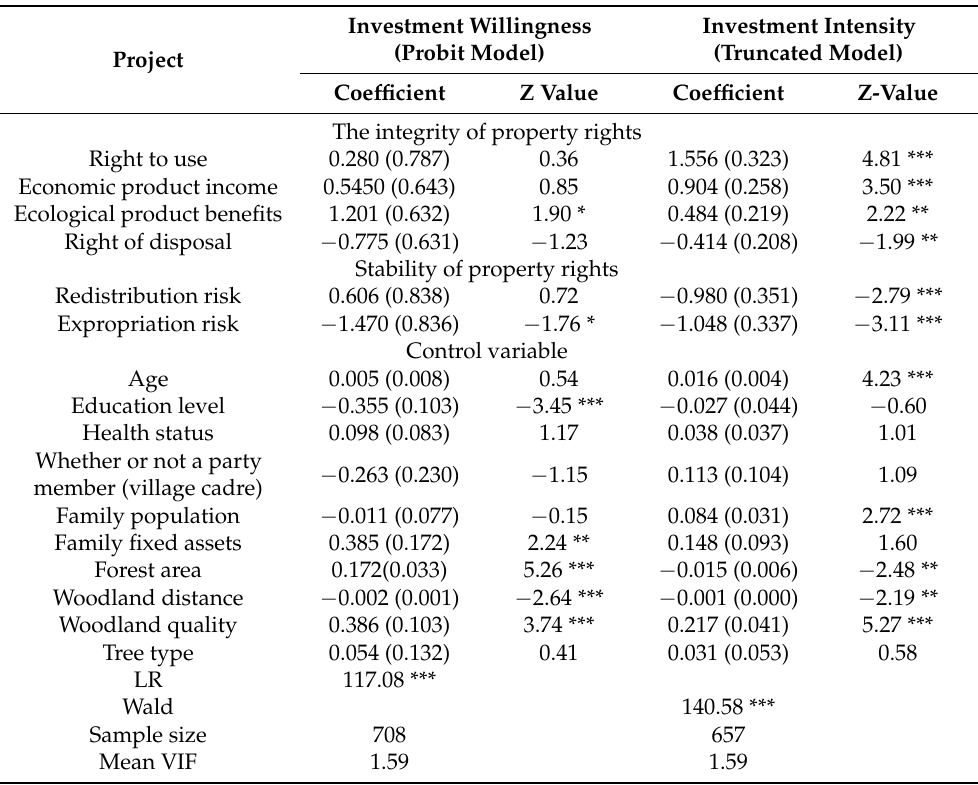
Table 3. Regression results of the impact of collective forest rights on farmers’ forestry investment, based on separation of economic property rights and ecological property